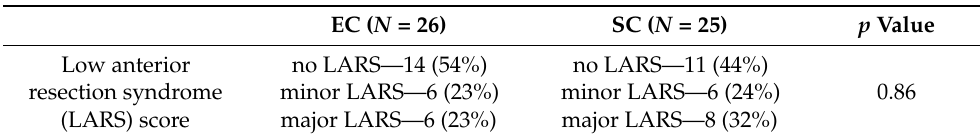
Table 2. Low anterior resection syndrome (LARS) score for patients undergoing early (EC) or